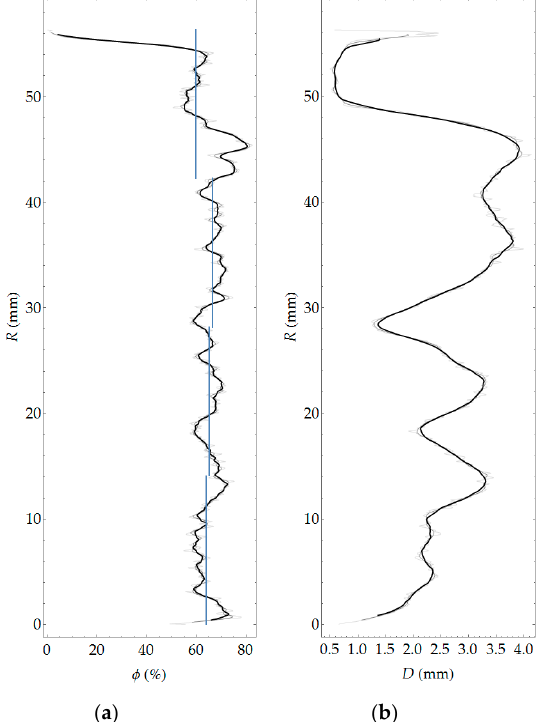
Figure 16. Volume fraction ( a ) and average aggregate thickness ( b ) as a function of coordinate R .